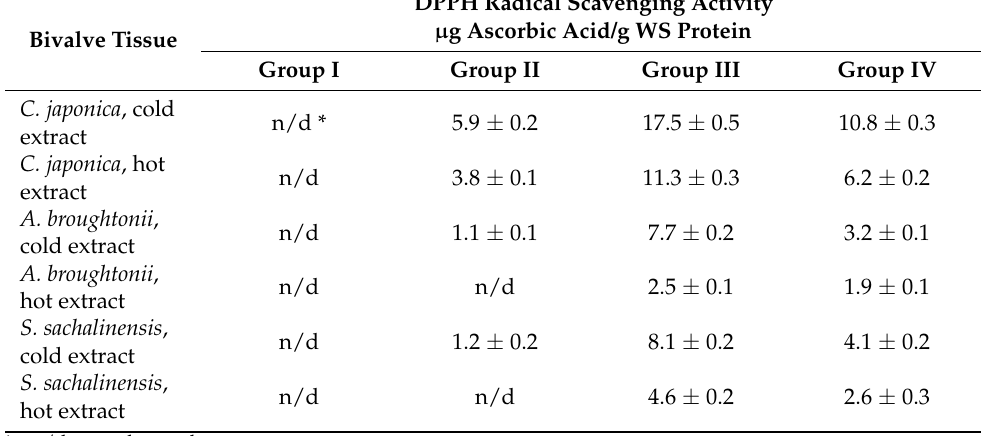
Table 5. The DPPH radical scavenging activity of the molecular fractions of the water extracts of bivalve